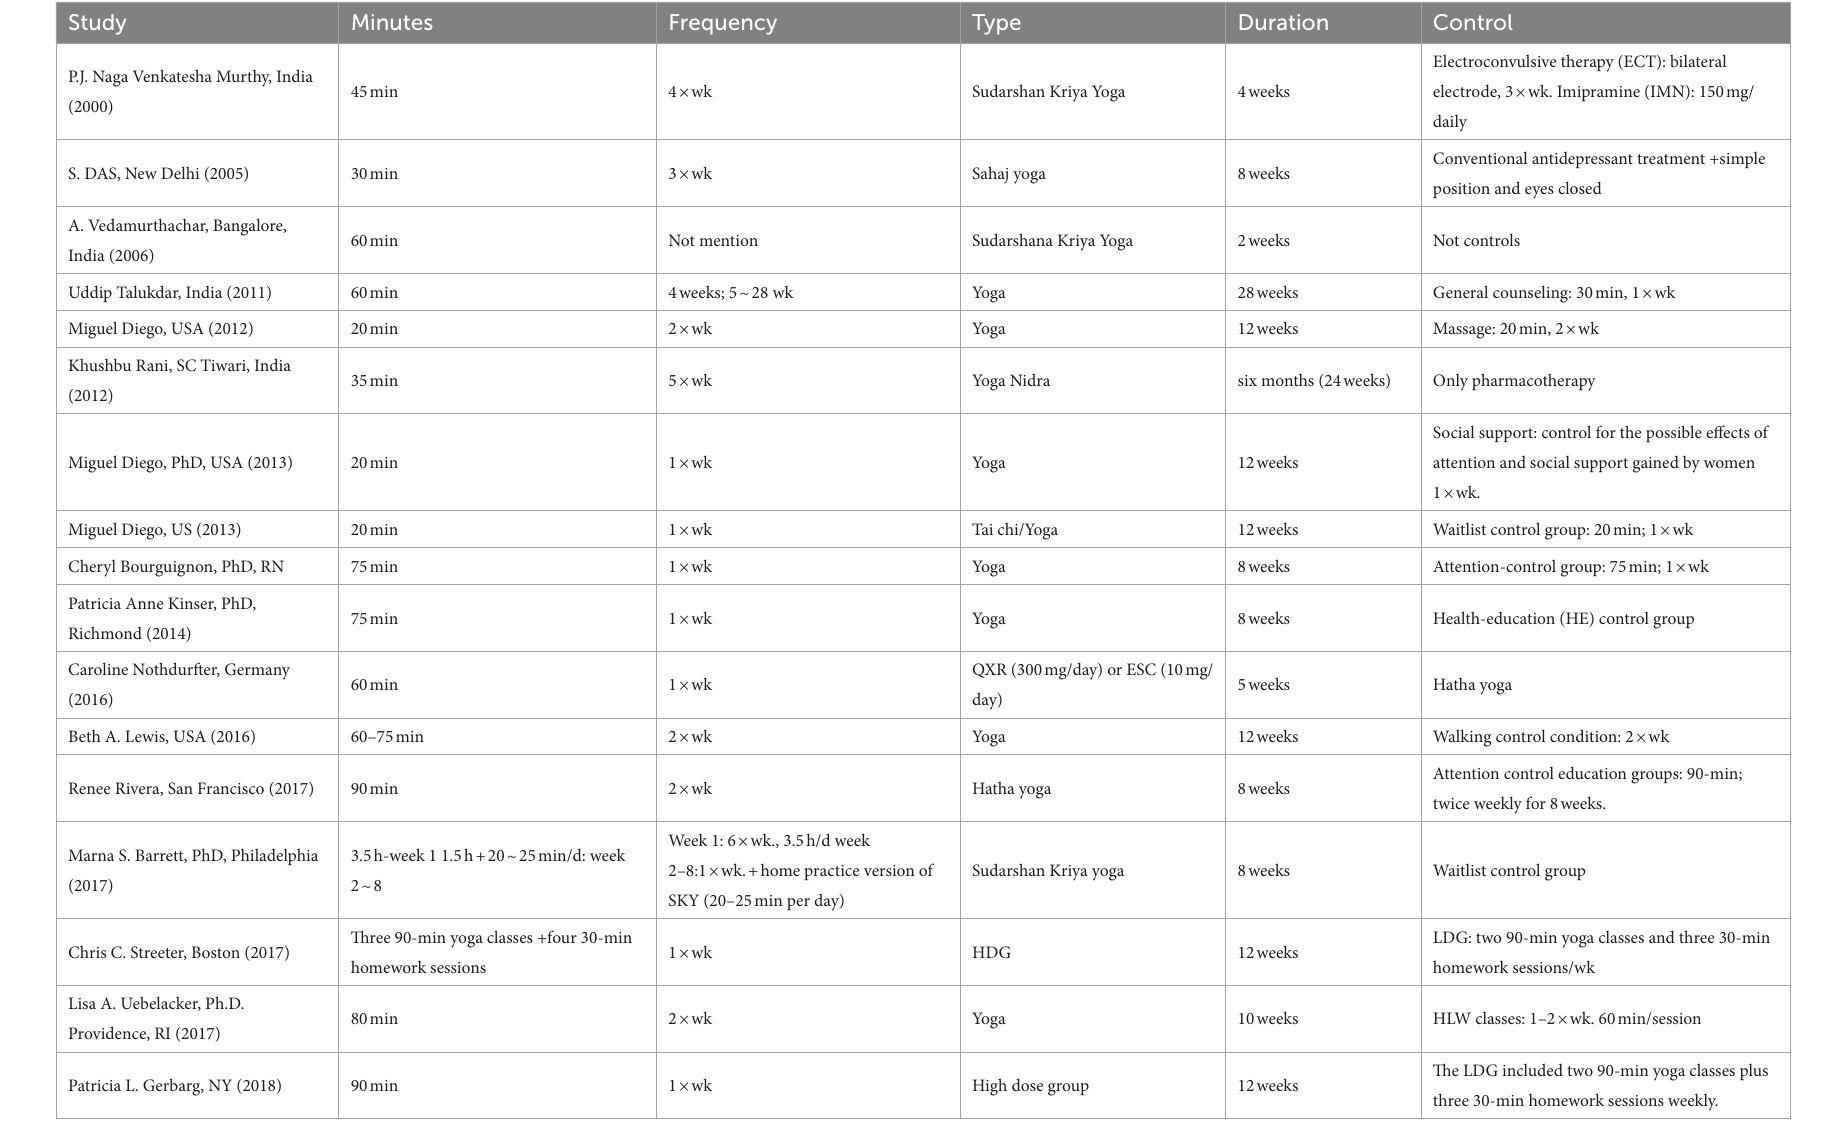
TABLE 2 Types of the invention used in included studies in the meta-analysis.